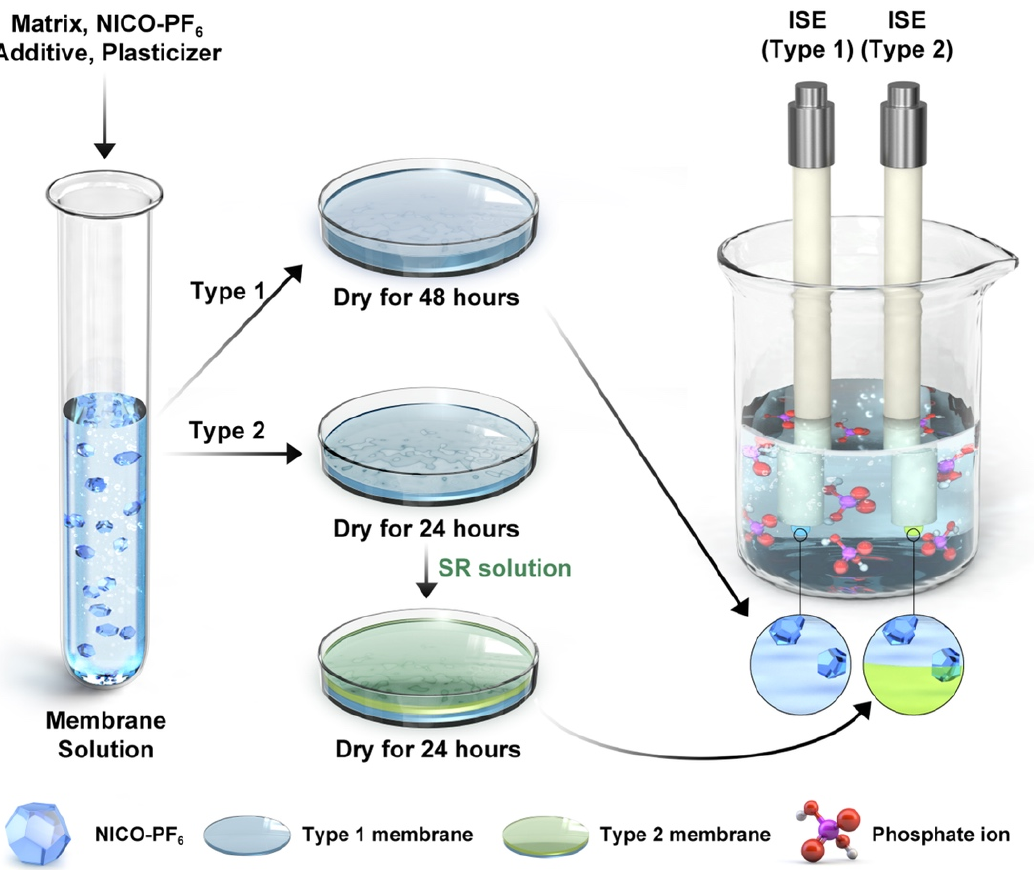
Figure 1. Fabrication of Type 1 and Type 2 ISE membranes composed of ionophore ( bis-meta- NICO-PF 6 ).